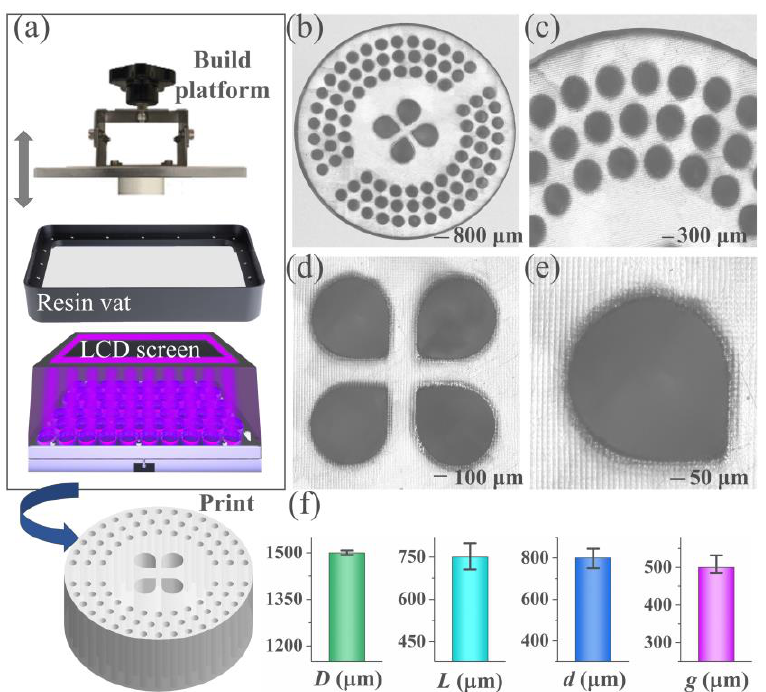
Figure 3. ( a ) Schematic of the SLA printing process and 3D printed object. Optical microscopy images of ( b ) the cross-section of the THz PC waveguide, ( c ) the periodically arranged unit cells of the THz PC waveguide, ( d ) the lilac-shaped resonant cavities of the THz PC waveguide, and ( e ) one petal of the lilac-shaped resonant cavities of the THz PC waveguide. ( f ) Statistical analysis of the size of four parameters after multiple measurements.